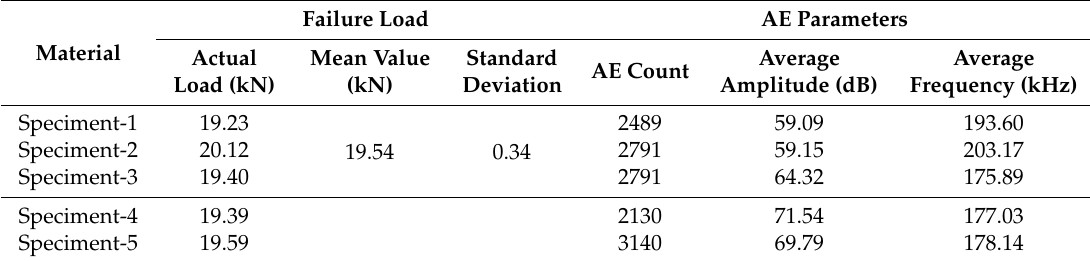
Figure 6. The tensile loading curve versus displacement for the composite specimen. Table 2. Summary of measured mechanical properties and corresponding AE characteristics.